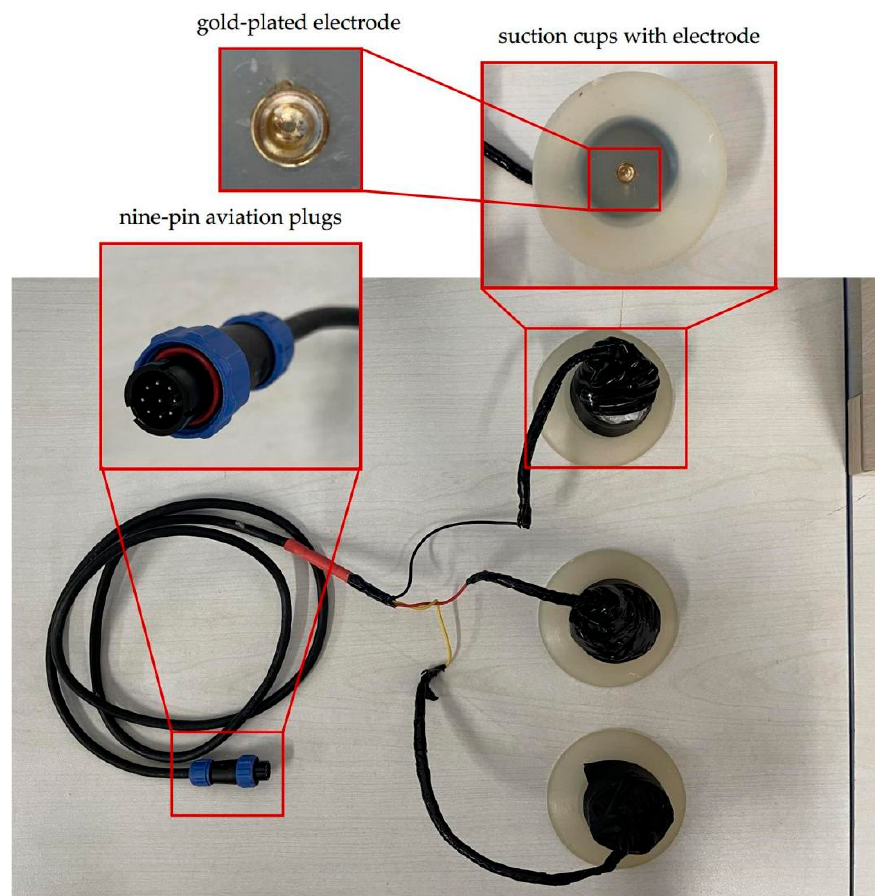
Figure 2. A customized silicone suction cup with an embedded gold-plated EEG electrode.